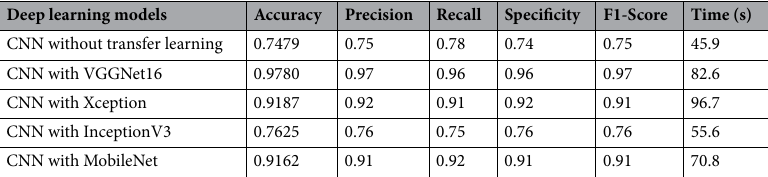
Table 3. Performance analysis of test data using deep learning technique (Technique 3).